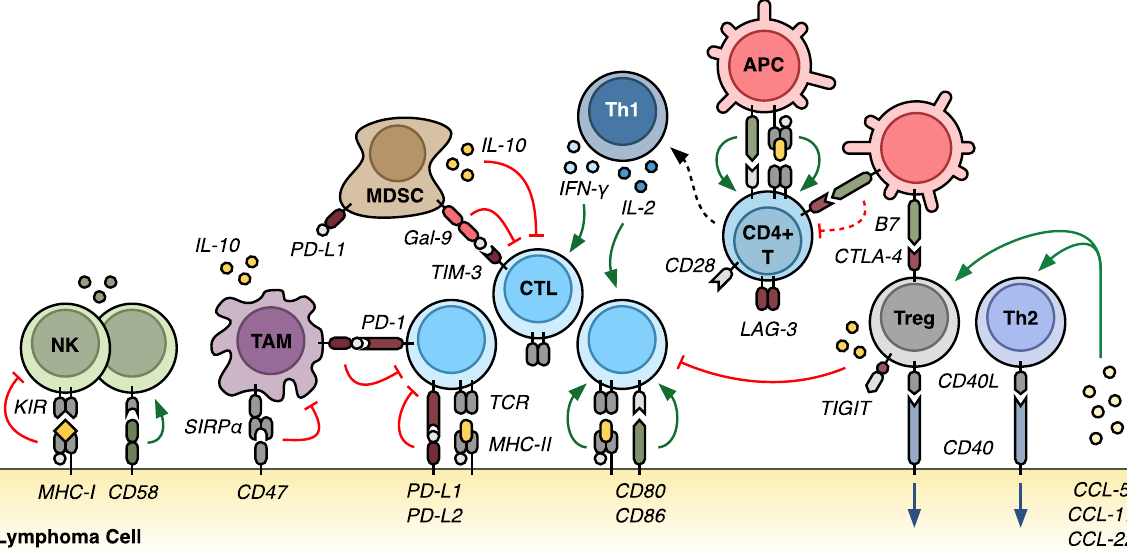
Figure 1. The tumor microenvironment in lymphoma. Numerous inhibitory and stimulatory interactions shape the lymphoma microenvironment. Activation of CD8+ cytotoxic T-lymphocytes (CTLs) requires two steps, including T-cell receptor (TCR) recognition of a peptide antigen in the context of major histocompatibility complex (MHC) and costimulation between CD28 and a B7 protein family member (CD80 or CD86). CTL proliferation and activity can be further supported by interferon gamma (IFN-γ) and interleukin 2 (IL-2) secretion, largely by proinflammatory CD4+ T-helper 1 (Th1) cells. Antigen-presenting cells (APCs) can also present MHC-restricted epitopes to CD4+ T-cells; however, T-cell expression of cytotoxic T-lymphocyte antigen 4 (CTLA-4) competes with costimulatory CD28 to dampen T-cell activation. The protein product of lymphocyte activation gene 3 (LAG-3) similarly competes for binding to MHC-II. Multiple T-cell populations— including regulatory T-cells (Tregs)—express T-cell immunoreceptor with immunoglobulin and ITIM domains (TIGIT), which both reduces IFN-γ secretion and promotes immunosuppressive interleukin (IL)-10 release. This cytokine signaling, combined with the secretion of various chemokine ligands (CCL-5, 17, and 22) by the lymphoma cells, recruits Th2 cells, myeloid-derived suppressor cells (MDSCs), and tumor-associated macrophages (TAMs) to the environment. The Th2 cells support lymphoma cell growth by means of interactions between CD40 and the CD40 ligand (CD40L). MDSCs express galectin-9 (Gal-9), which binds to T-cell immunoglobulin and mucin domain 3 (TIM-3) to drive T-cell exhaustion. TAMs, MDSCs, and some lymphoma subtypes also express programmed cell death ligands 1 and 2 (PD-L1 and PD-L2), which further impair T-cell function and, ultimately, lead to T-cell apoptosis. Lymphoma cells further shield themselves from the innate immune system via the expression of CD47, which binds to signal regulatory protein alpha (SIRPα) on TAMs to inhibit phagocytosis. MHC-mediated interactions with killer cell immunoglobulin-like receptor (KIR) on NK cells provide additional self-tolerance against NK-mediated cytotoxicity. Collectively, these various signals and interactions create an environment of immune dysfunction that sustains and promotes malignant